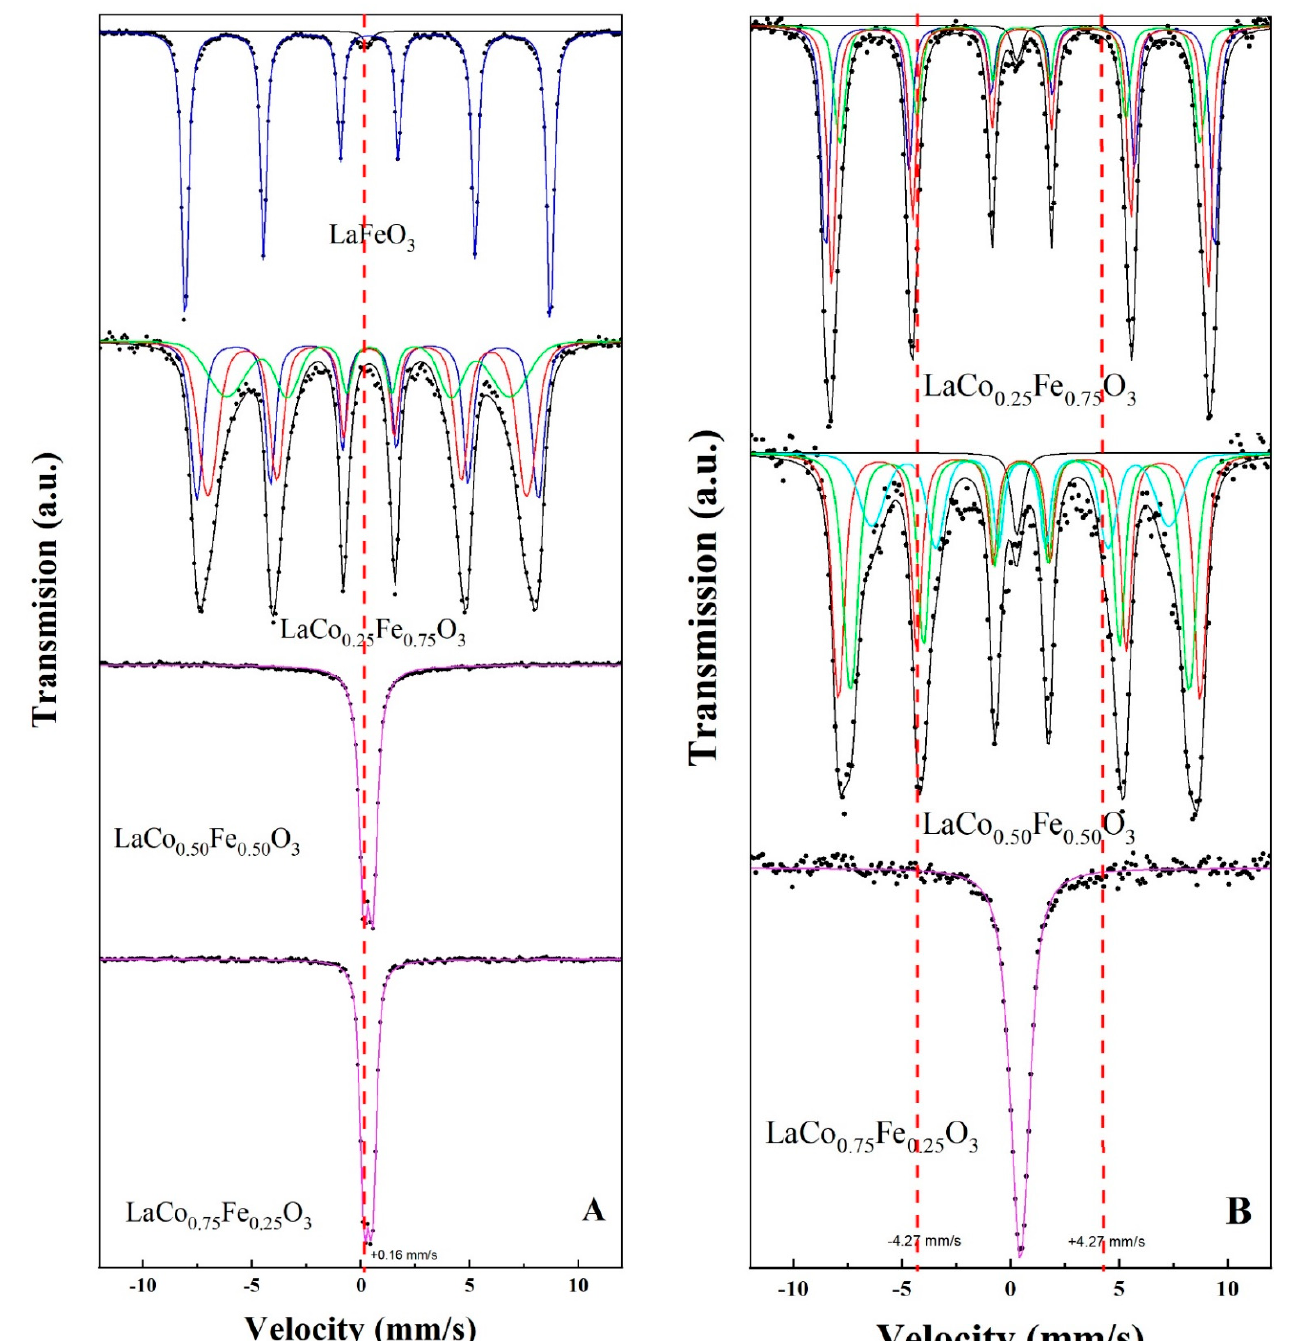
Figure 5. Mössbauer spectra: ( A ) at 298 K and ( B ) at 12 K. Table 5. Hyperfine Mössbauer parameters of LaFeO 3 , LaCo 0.25 Fe 0.75 O 3 , LaCo 0.5 Fe 0.5 O 3 , and